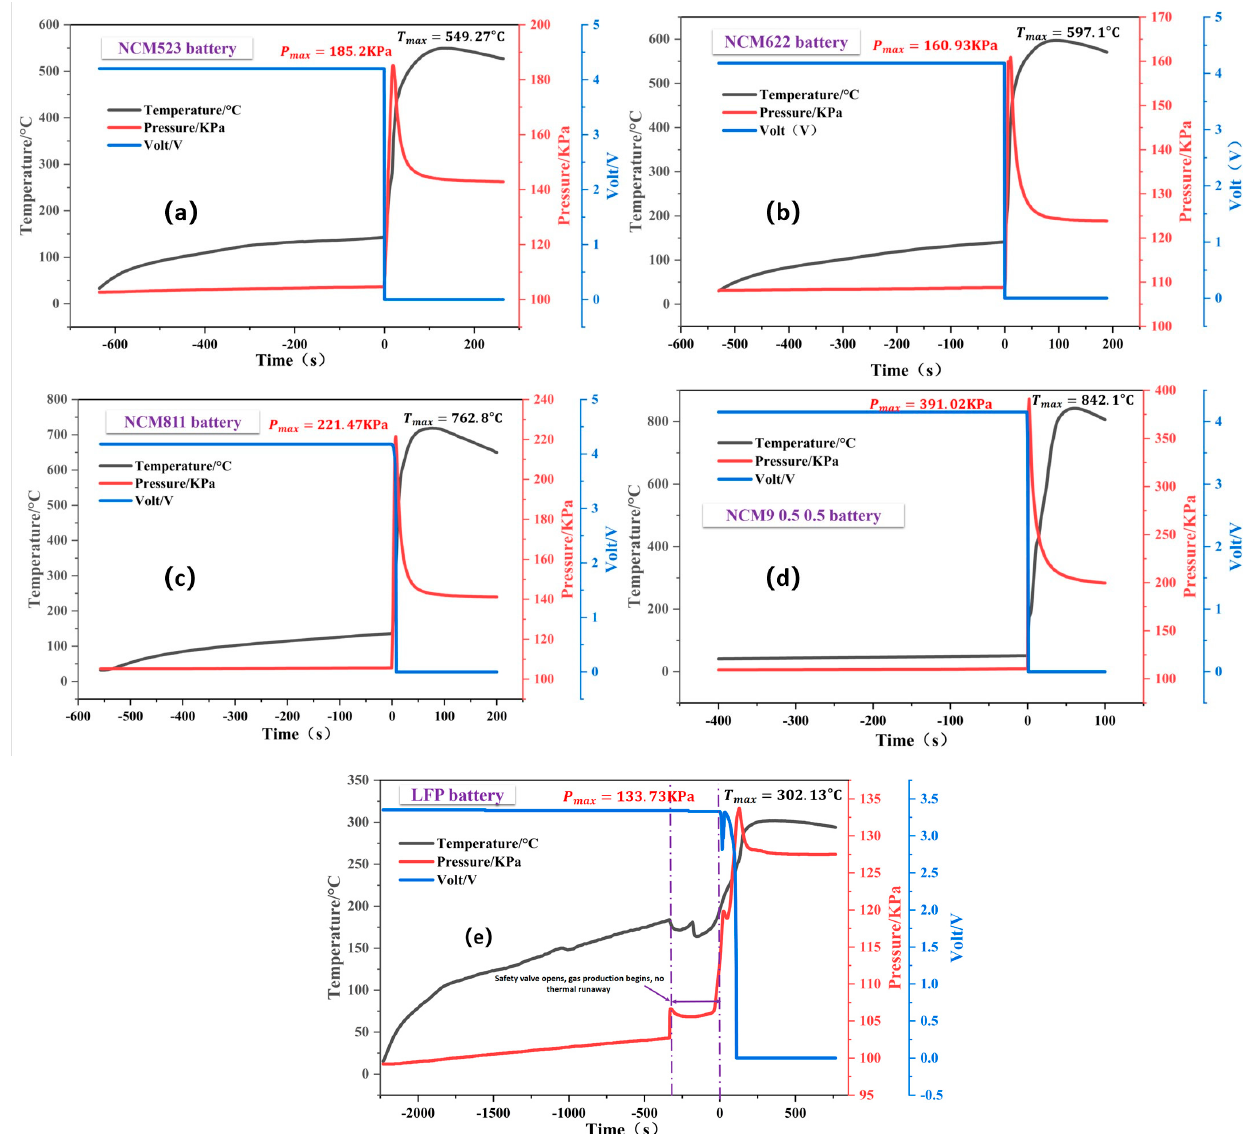
Figure 4. Subfigures ( a – e ) show the experimental data curves for the temperature, chamber pressure, and battery voltage during the experiments for NCM523, NCM622, NCM811, NCM9 0.5 0.5, and LFP batteries, respectively.